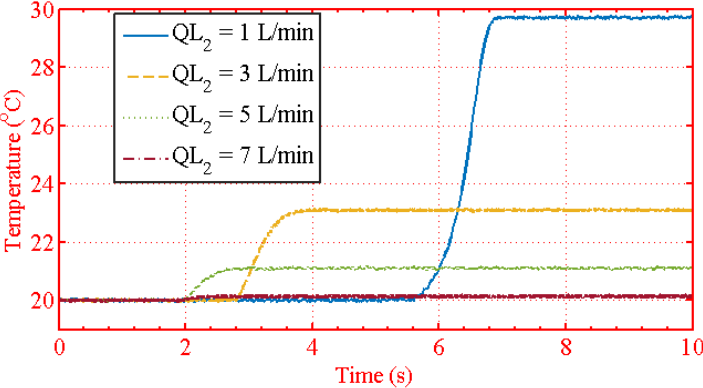
Figure 22. The output temperature in cold fluid with QL 1 = 1